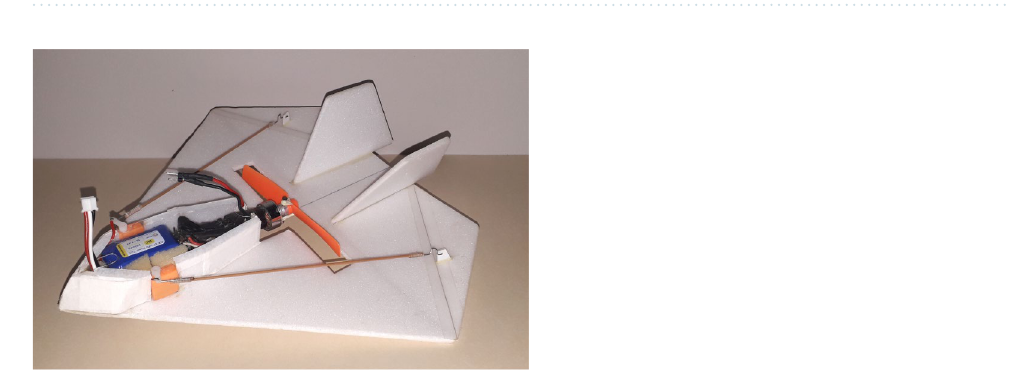
Figure 15. Final prototype measures.